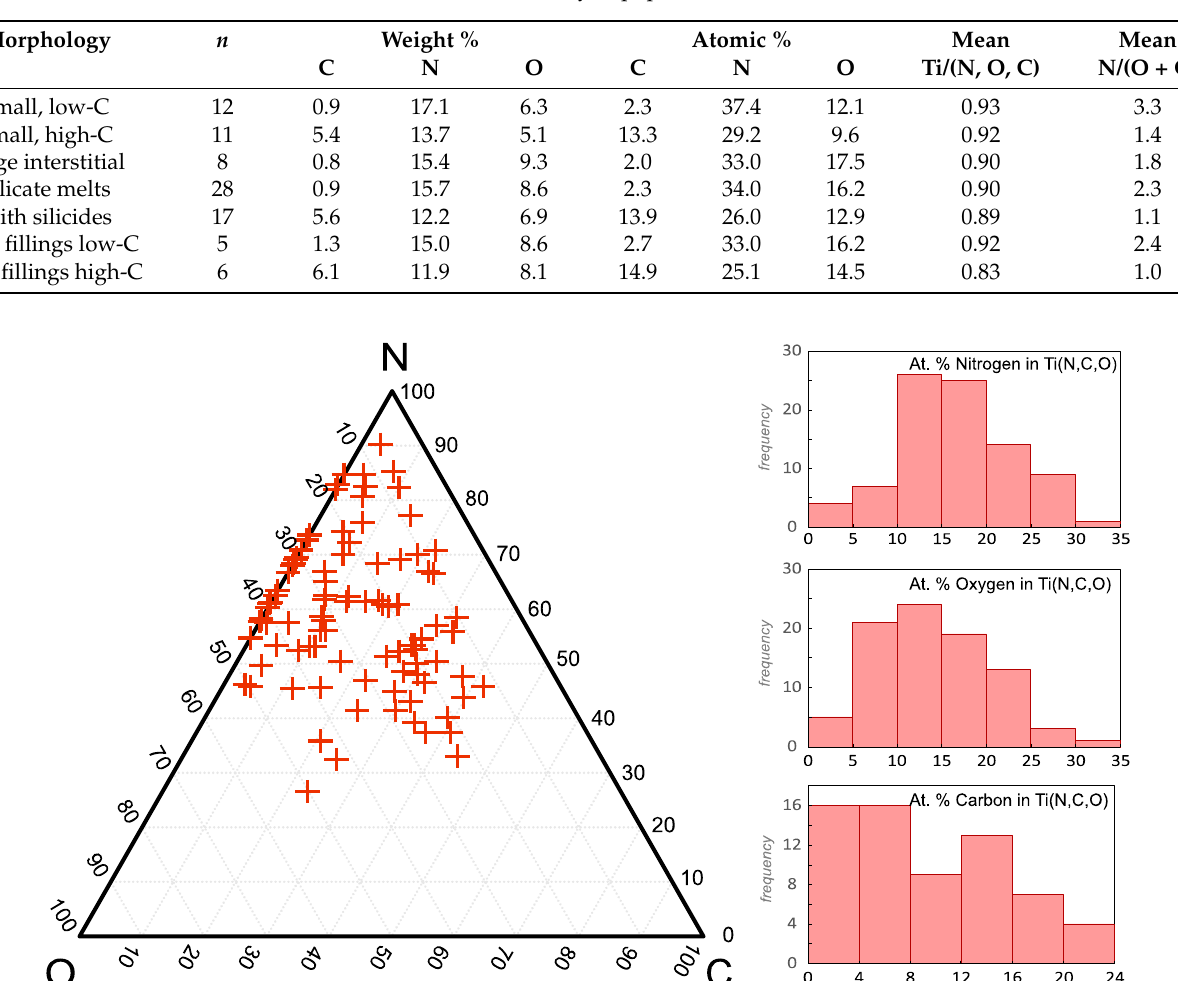
Figure 9. ( Left ) Ternary plot illustrating overall negative correlation between C and N contents over a range of O contents. ( Right ) Histograms showing abundances of N, O and C in the analyzed Ti nitrides, classified according to paragenesis (Table 1).